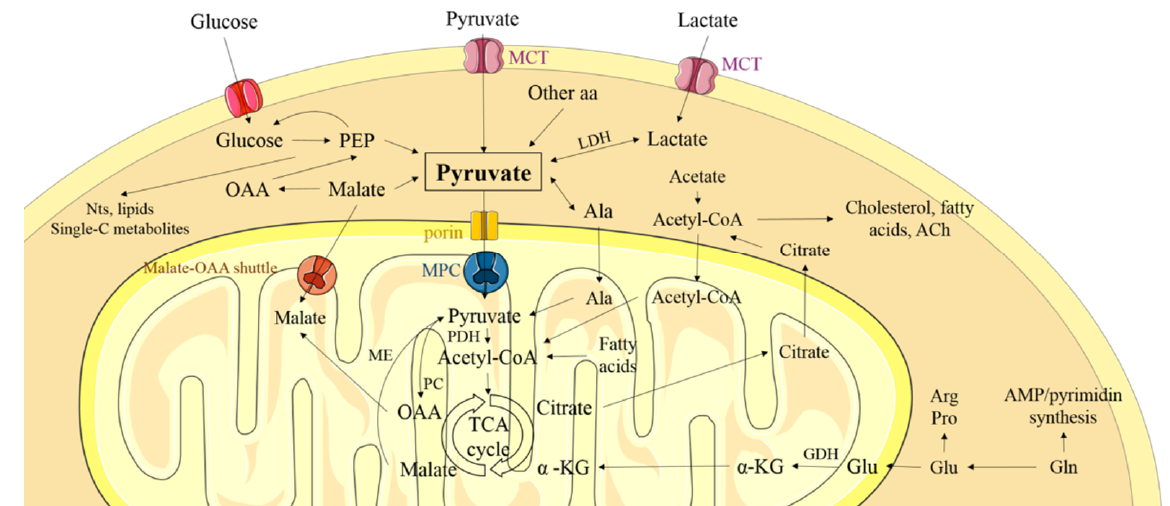
Figure 1. Pyruvate transport and metabolism in the cell. Pyruvate is derived from glucose, lactate, malate, and amino acids (aa). Under aerobic conditions, pyruvate enters the mitochondrion by crossing the outer membrane (OM) via porins, and the inner membrane (IM) via the mitochondrial pyruvate carrier (MPC) complex. Once inside, it enters the tricarboxylic acid (TCA) cycle to provide energy or intermediates for other biosynthetic reactions. Under hypoxic conditions, pyruvate is reduced to lactate in the cytosol, which is then secreted. PEP: phosphoenolpyruvate; LDH: lactate dehydrogenase; MCT: monocarboxylate transporters; α -KG: α -ketoglutarate; GDH: glutamate